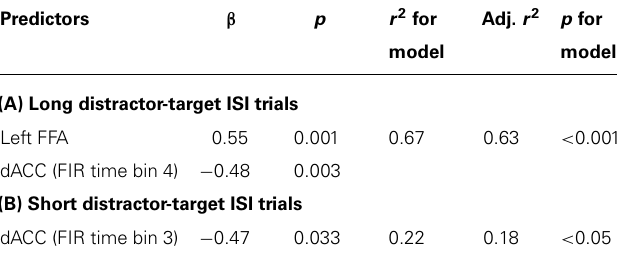
FIGURE 3 | DorsalACC (dACC) activity to moderate versus strong threat distractors: relationship with speed of letter target identification (A) and trait anxiety (B). (A) A finite impulse response (FIR) model was used to extract dACC activity from time bins 3 and 4 (4–6 and 6–8 s, respectively) post distractor presentation. For short distractor-target ISI trials, time bin 3 activity may reflect neuronal activity at a time just prior to, through to concurrent with, letter string onset; whereas for long distractor-target ISIs, this is more likely to be captured by time bin 4 activity. In line with this, on short distractor-target ISI trials, greater time bin 3 dACC activity was significantly associated with faster letter target identification following moderate versus